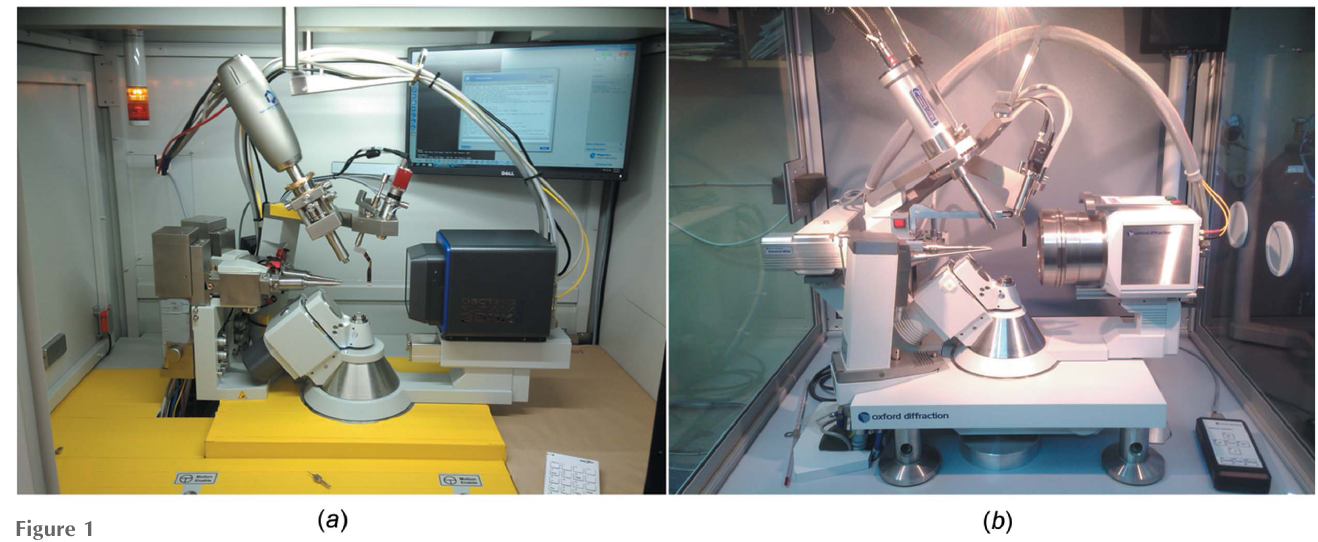
Figure 1 Cabinet view of diffactometers used: ( a ) XtaLAB Synergy-S Dualflex; ( b ) Oxford Diffraction Gemini R